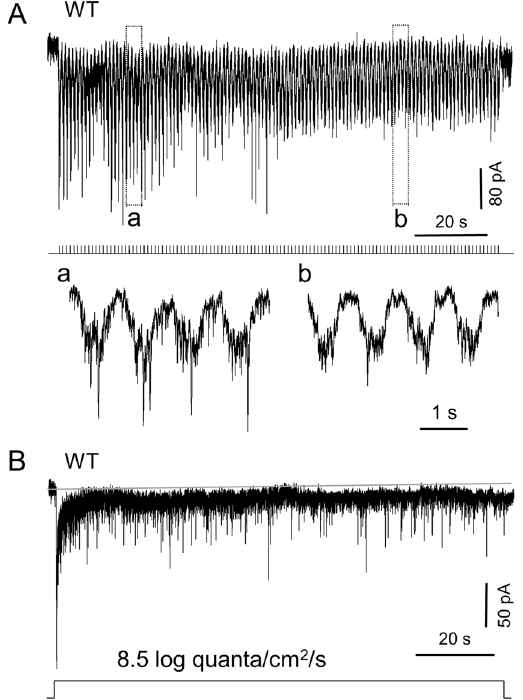
Figure 5. Rods contribute to DAC responses to dim steady background or flashing light. Experiments were conducted using wild-type mice. An intensity of 8.5 log quanta/cm 2 /s white light (which only activates rod photoreceptors) was used for stimuli. ( A ) A 500 ms-duration, 1 Hz flashing light was applied to the retina for 2 min. Traces in boxes a and b are time-expanded to show detailed response dynamics. The pattern of light stimuli is illustrated below the trace as a series of tick marks. ( B ) A rod-mediated DAC response was evoked using a 2 min steady background light stimulus. The sustained inward current evoked by the first light pulse remained constant throughout the 2 min stimulus. Solid gray line indicates the resting current